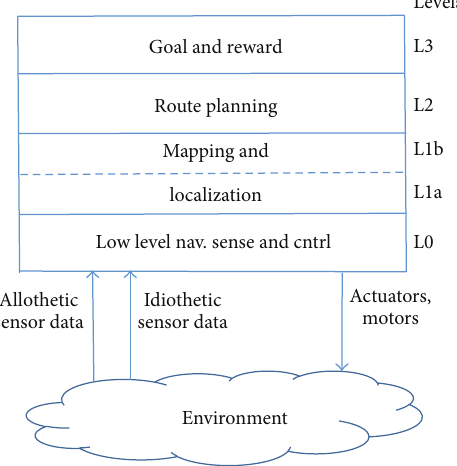
Figure 1: A generic SLAM based hierarchal architecture that can apply to both classical and neurobiologically based mobile robot